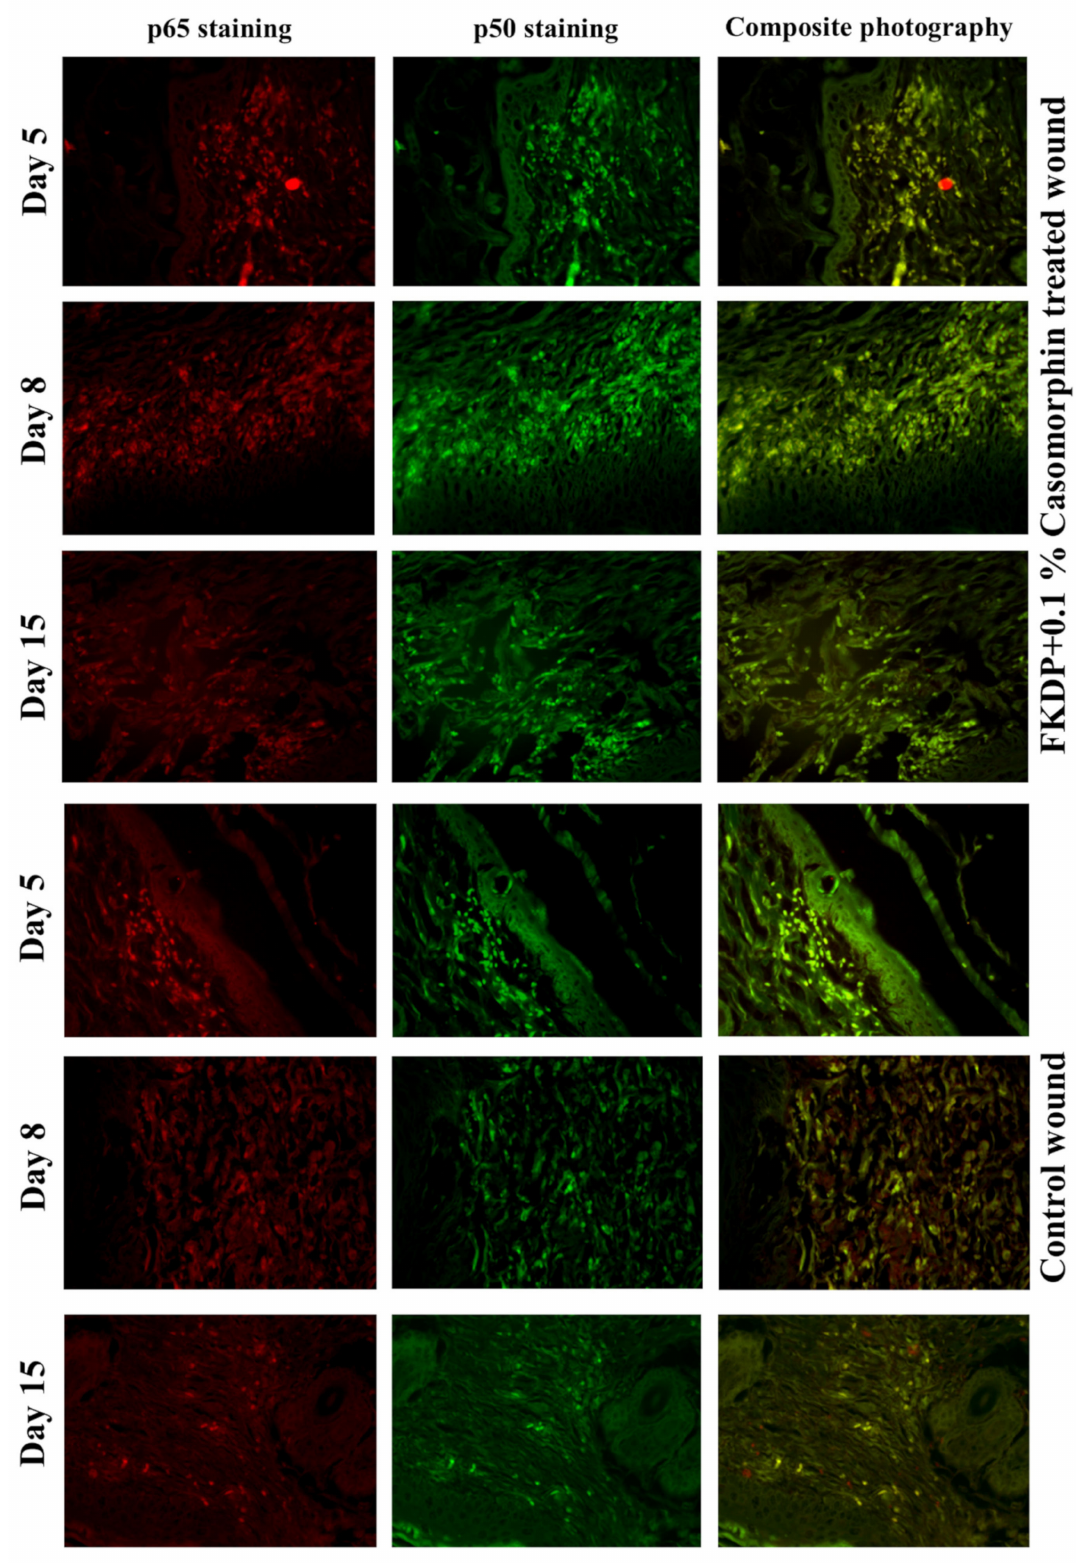
Figure 6. Tissue biopsy taken from FKDP + 0.1%Caso (3 upper panels) treated wound and control wound (lower panel) immunolabeled for p 65 (red), p 50 (green). Note the changes in immunoreactive cell numbers during the healing course (color online, black & white in